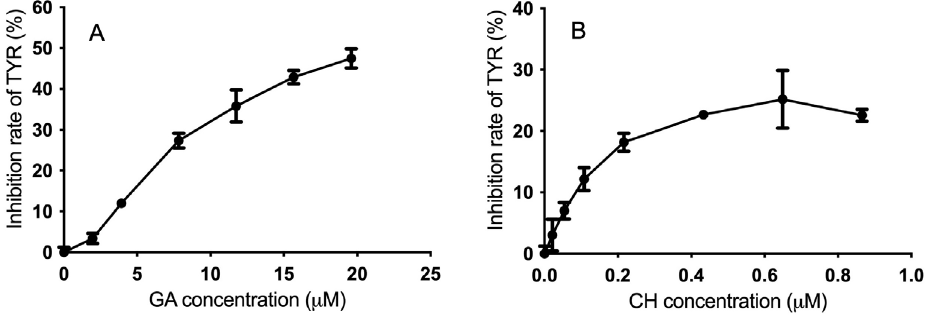
Figure 4. Concentration – response curves of ( A ) GA and ( B ) CH on TYR inhibition ( n = 3). GA, gallic acid; CH, catechin hydrate; TYR, tyrosinase. acid; CH, catechin hydrate; TYR,